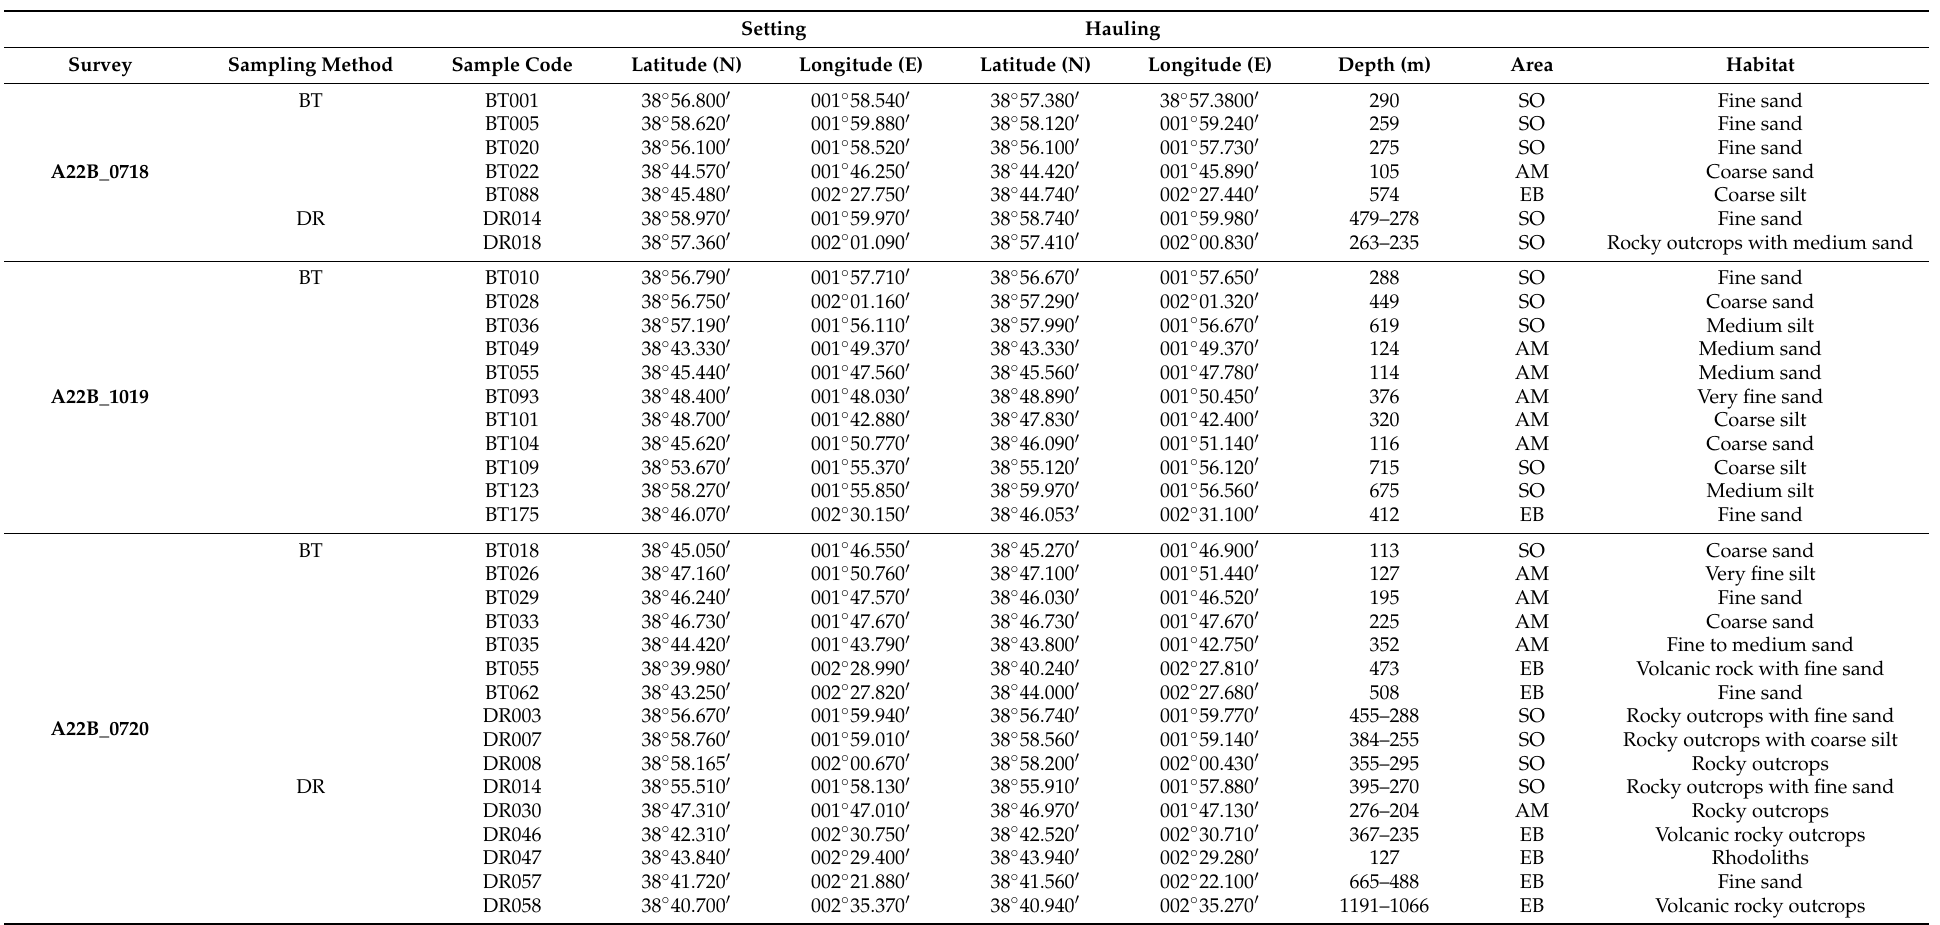
Table 1. Information on the stations where new records of Mollusca were found in the seamounts of the Mallorca Channel (Balearic Islands, western Mediterranean): Ses Olives (SO), Ausias March (AM) and Emile Baudot (EB). Samples were collected with beam-trawl (BT), rock dredge (DR) during the INTEMARES surveys developed between 2018 and 2020. Depth range and mean depth for DR and BT stations, respectively are also